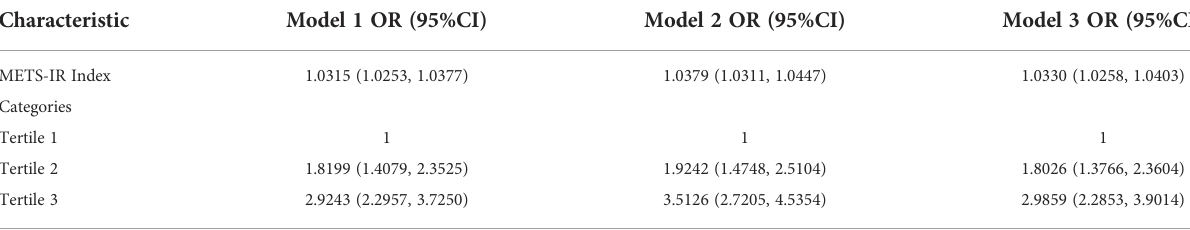
TABLE 2 Analysis between METS-IR index with gallbladder stone prevalence.